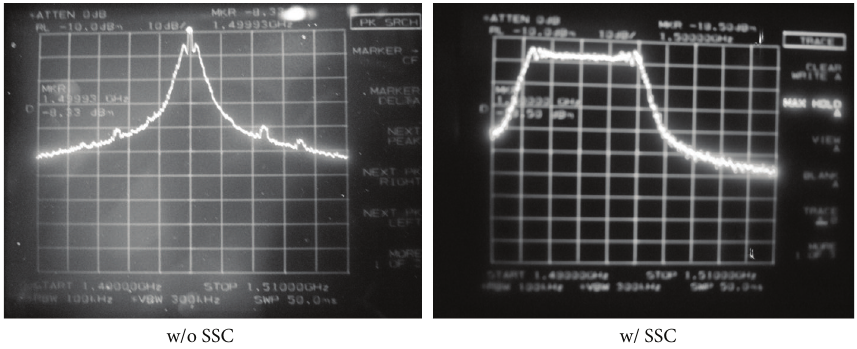
Figure 21: Measurement results of the SSCG output signal spectrum with and without SSC.